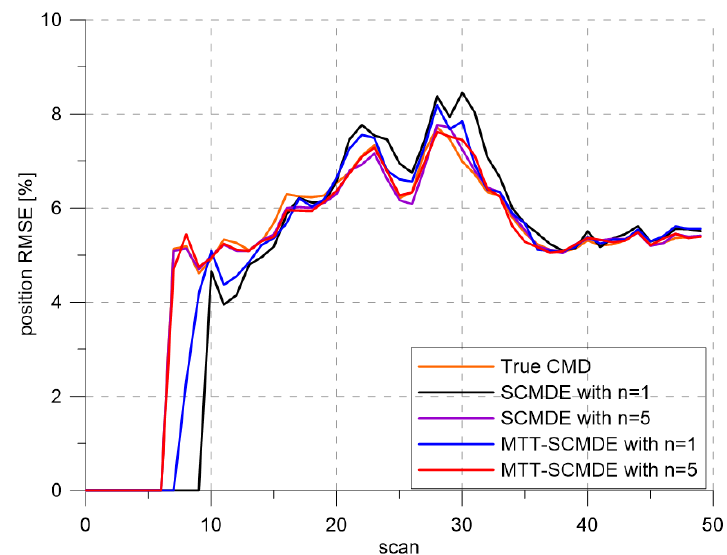
Figure 10. Position RMSE.